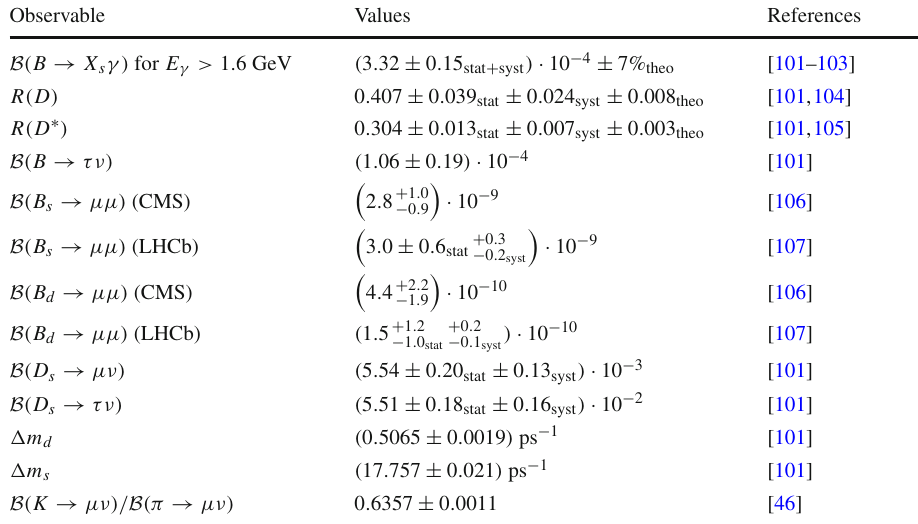
observables and values used in the 2HDM fit